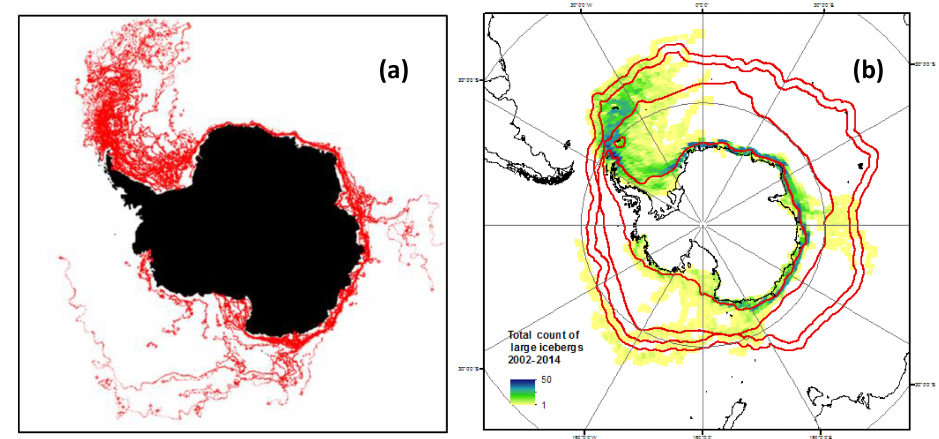
Figure 6. Spatial distribution of large icebergs: (a) all iceberg tracks between 1999 and 2010 (from http://www.scp.byu.edu/data/iceberg/ database1.html); (b) gridded count of iceberg occurrences between 2002 and 2014. Table 4. Impact of large icebergs on NPP: comparison of mean NPP of iceberg grids, adjacent grids, and nearby grids. Zone Mean NPP of Mean NPP of Mean p ∗ Mean NPP of Mean NPP of Mean p No. of iceberg grids adjacent grids diff. value iceberg and nearby grids diff. value ∗ iceberg (mgCm − 2 d − 1 ) (mgCm − 2 d − 1 ) adjacent grids (mgCm − 2 d − 1 ) grids (mgCm − 2 d − 1 ) per year CSZ 241 ± 6 . 5 241 ± 5 . 9 0.62 0.84 242 ± 6 . 0 215 ± 4 . 6 27.17 0.00 73.08 SIZ 206 ± 5 . 0 210 ± 5 . 1 − 4.61 0.05 209 ± 4 . 9 189 ± 3 . 8 20.03 0.00 60.92 POOZ 151 ± 5 . 8 148 ± 5 . 1 2.19 0.25 149 ± 5 . 2 149 ± 5 . 0 0.13 0.94 14.23 PFZ 249 ± 15 . 5 257 ± 14 . 8 − 8.91 0.02 256 ± 15 . 0 243 ± 12 . 7 13.06 3.77 Total 219 ± 3 . 7 220 ± 3 . 5 − 1.72 0.33 220 ± 3 . 5 199 ± 2 . 8 21.31 0.00